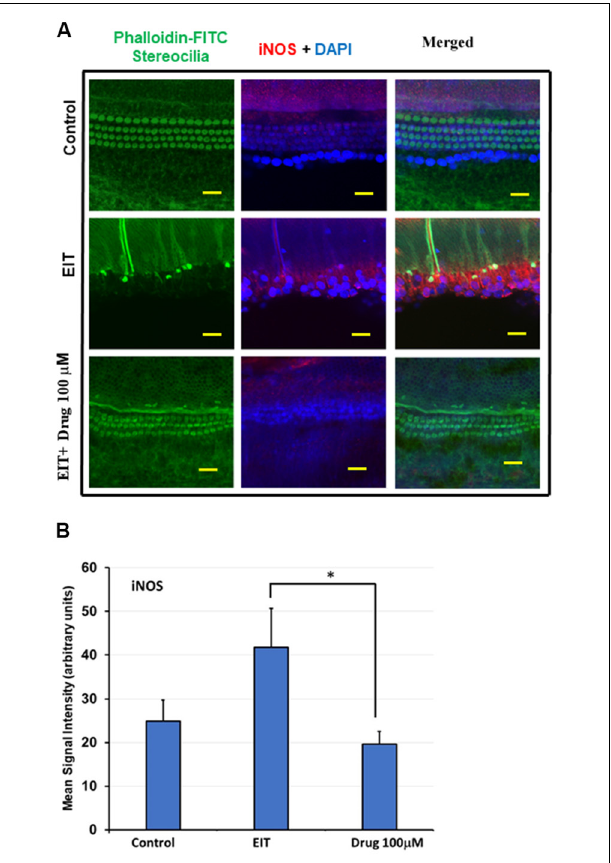
FIGURE 5 | TDCA reduces inducible nitric oxide synthase (iNOS) immunolabeling in OC explants subjected to EIT. (A) Representative images of iNOS immunolabeling in OC explants. The first column shows the explant’s stereocilia bundles stained with FITC-phalloidin. Cell nuclei were stained with DAPI (blue color). (B) Mean signal intensity for iNOS immunostaining was calculated using ImageJ software. Data are expressed as mean values ± SD and are representative of three independent experiments. ∗ P < 0.001 compared to the EIT group. n = 6 OCs per group. Scale bars: 10 µ